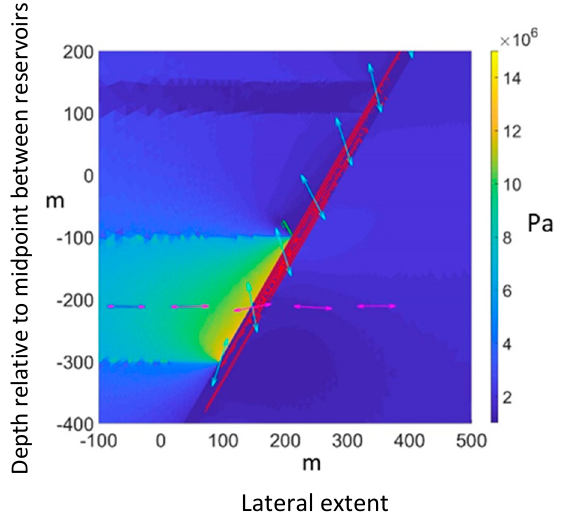
Figure 10. Visualization of principal stress rotation near the fault; maximum principal stress along the fault: light blue, minimum principal stress along the lower reservoir’s central line: pink. Horizontal effective stress magnitude in Pa.